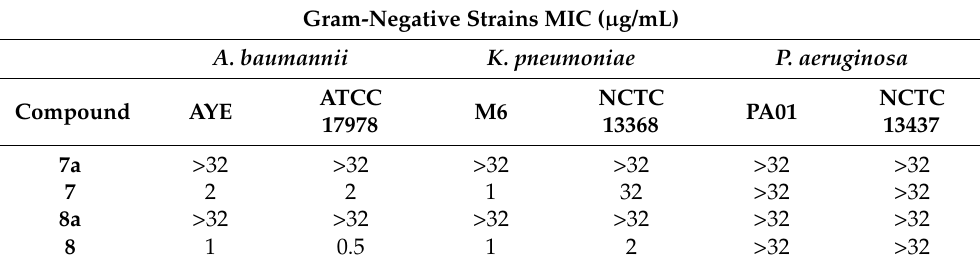
Table 2. MIC result against tested Gram-negative strains for compounds 7, 7a, 8, and 8a. Results in µ g/mL, at least three replicates